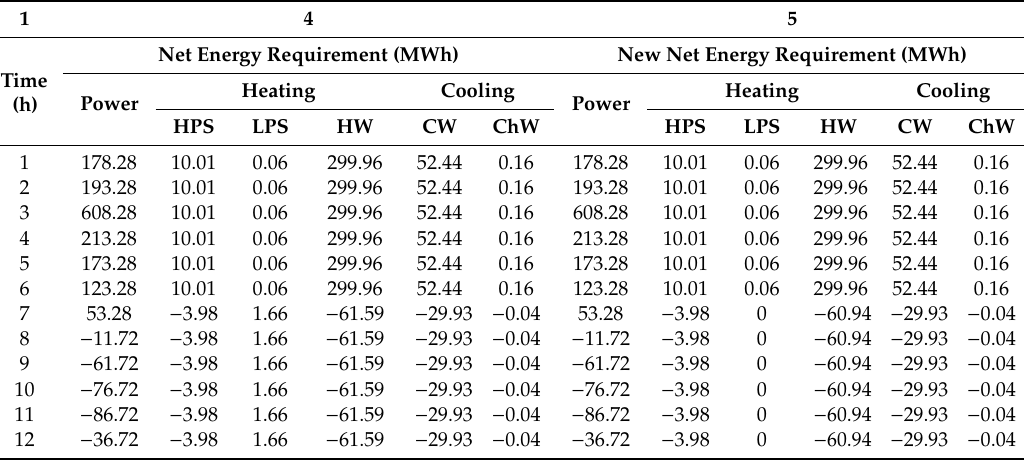
Table A21. TriGenSCA for final trigeneration PWR NPP without integration from time 1 to 12 h.